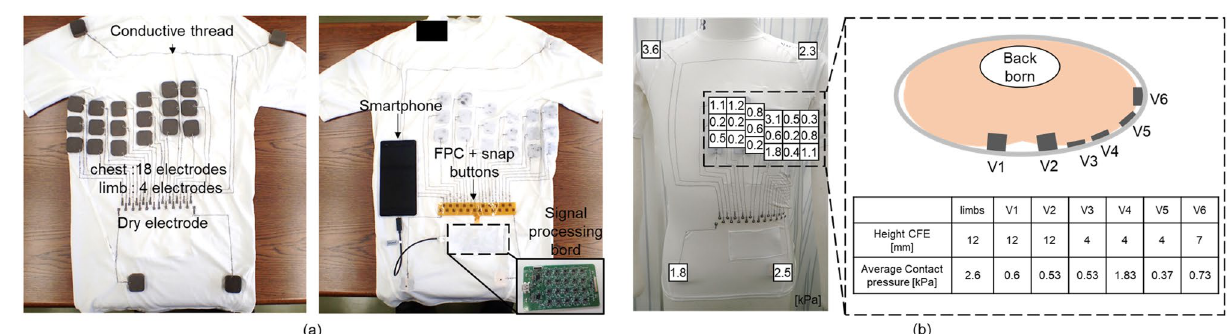
Figure 3. Multi-lead ECG wearable measurement device. Photographs of ( a ) rear side, and ( b ) front side of the wearable device. ( c ) Contact pressure distribution on the CFE, which was attached between the wearable device and the